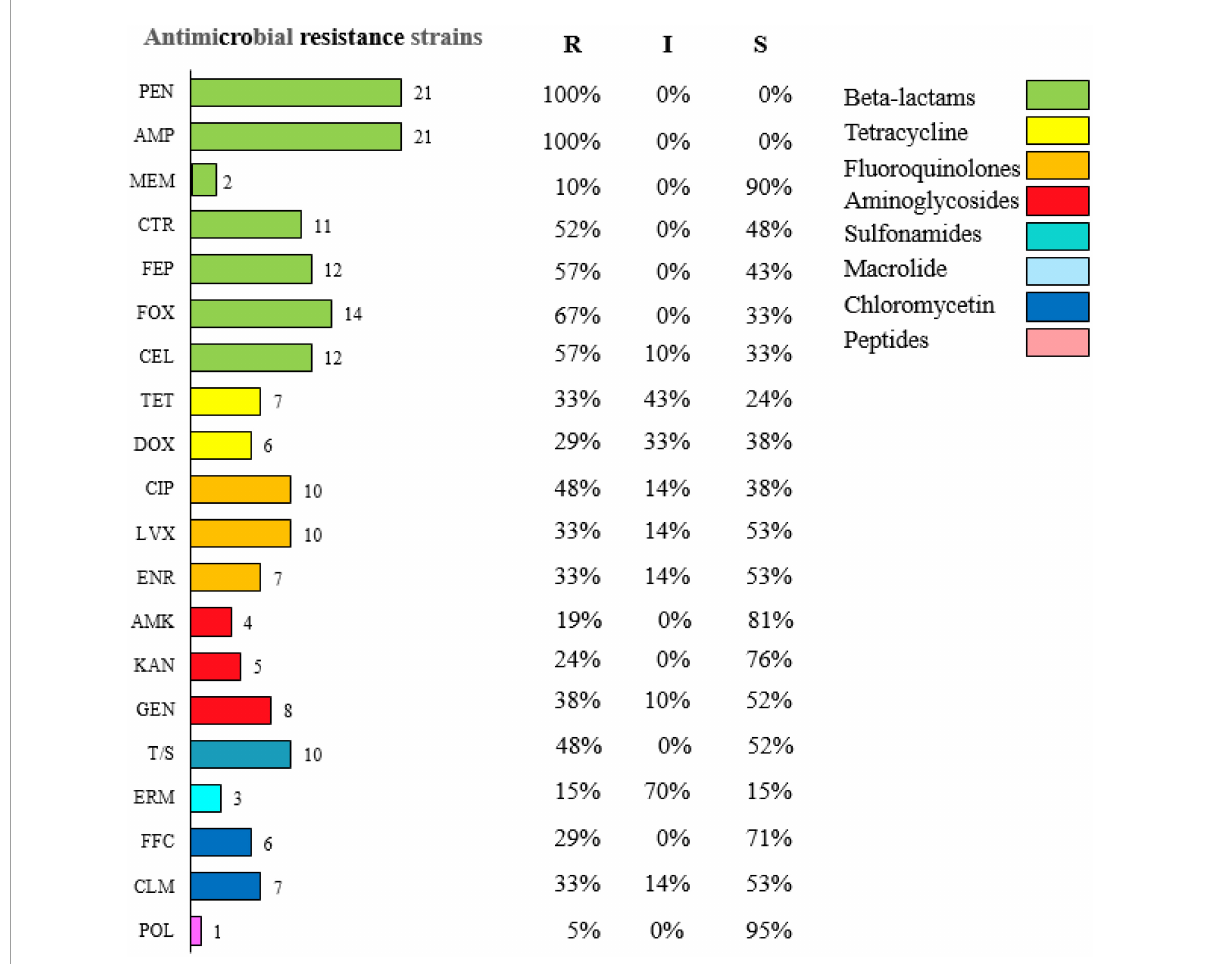
FIGURE1 Results of drug sensitivity tests for diarrheagenic calves source Escherichia coli